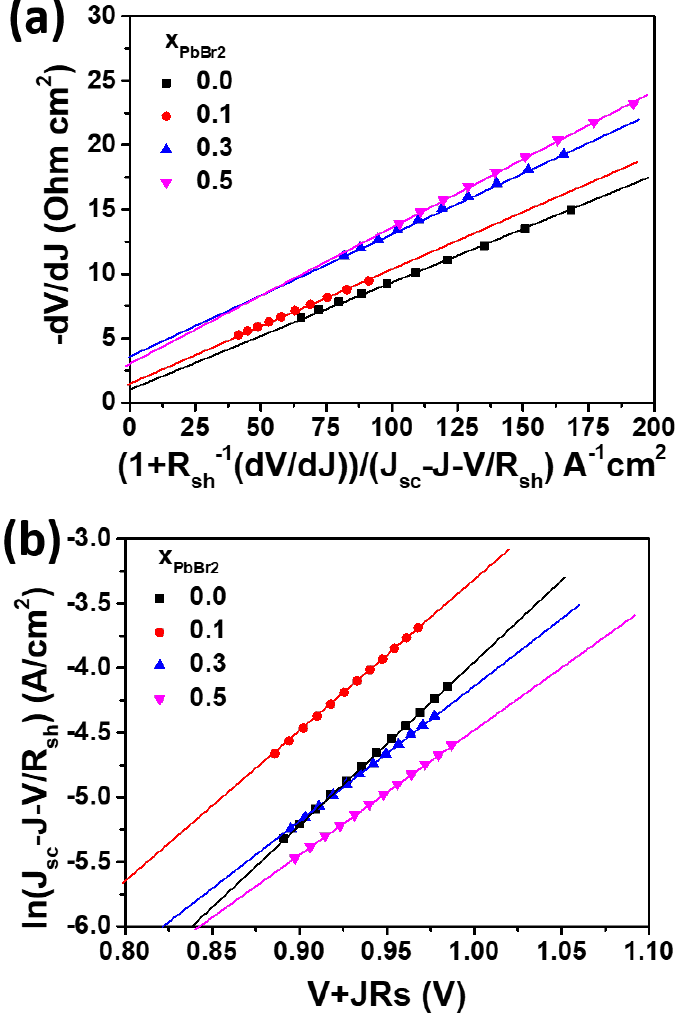
Figure 7. Plots of ( a ) − dV / dJ vs. (1 + R sh − 1 ( dV / dJ ))/( J sc − J − V / R sh ) for the solar cells fabricated at x = 0, 0.1, 0.3, 0.5 under illumination (linear fitting curves are shown), and ( b ) ln ( J sc − J − V / R sh ) vs. ( V + JR s ).